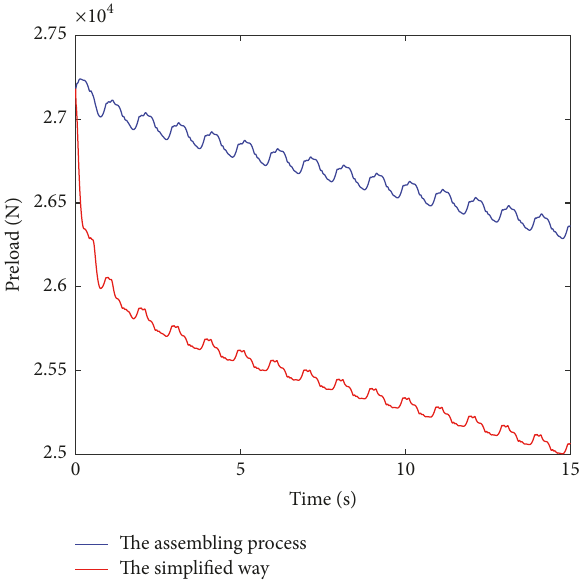
Figure 16: The preload variations under different fastening ways.